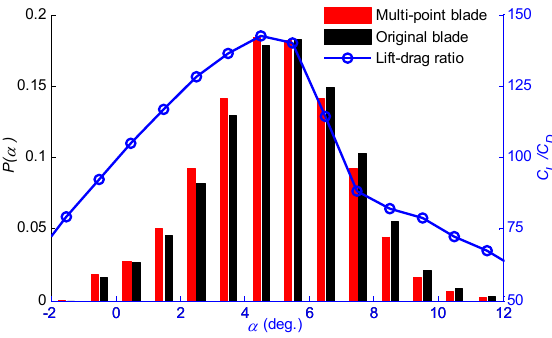
Figure 11. Probability distributions of angles of attack α for the blade elements chosen from the original and multi ‐ point optimized blades.